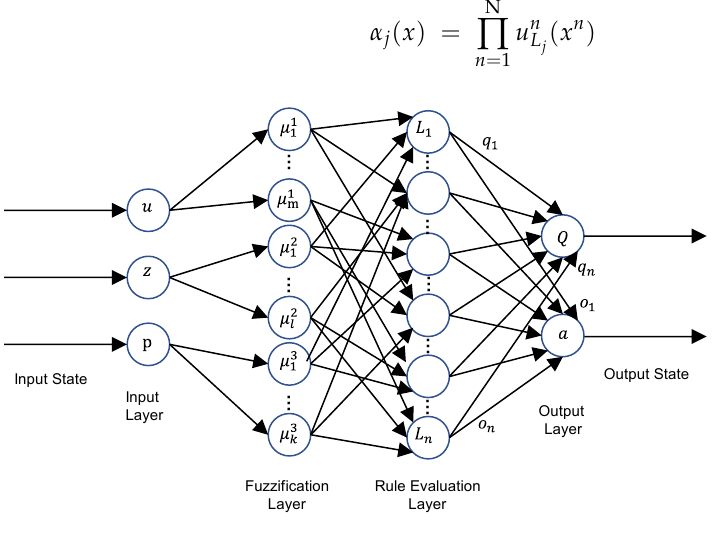
Figure 2. The FQL structure.